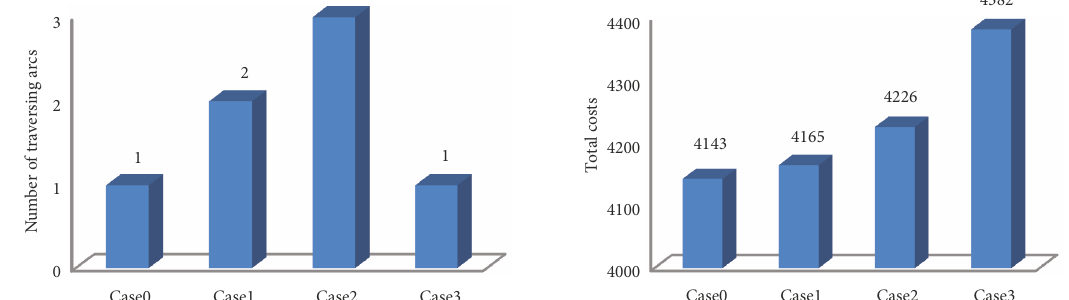
Figure 10. Effects of the tightening deadlines on the number of traversing arcs and total Table 6. Comparison effects of the tighter the deadlines of the proposed model with classical LARP Number of un-served required arcs Problem in the